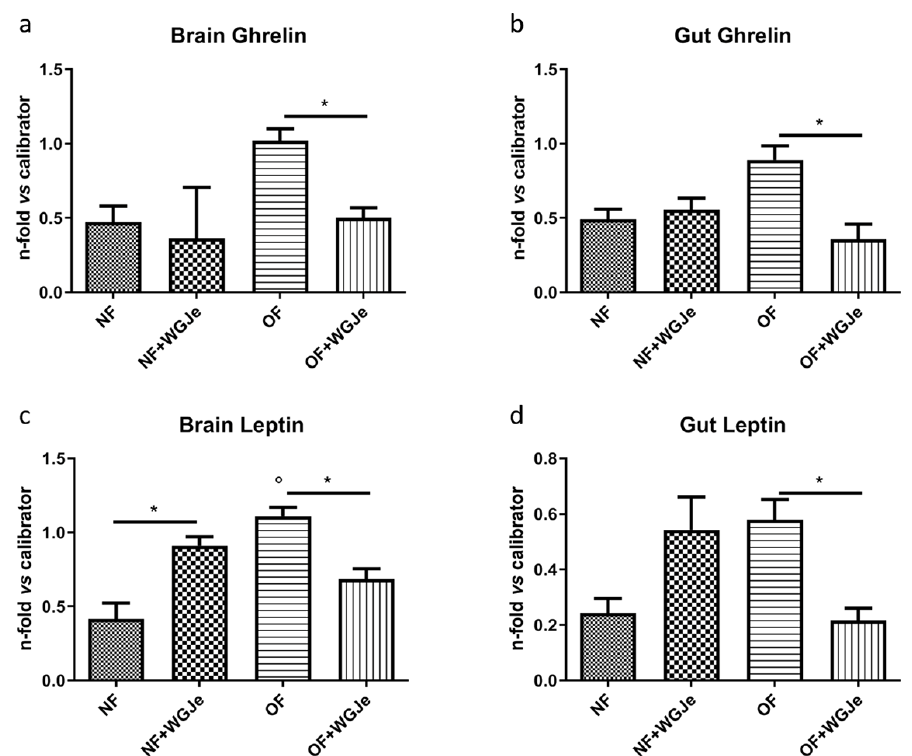
Figure 6. Effect of WGJe on the expression level of food-intake related genes. The expression of ghrelin ( a , b ) and leptin A ( c , d ) mRNA levels were investigated by qPCR analyses versus an arbitrary calibrator in both brain and gut of the normal fed (NF) and overfed (OF) groups, with and without WGJe treatment. Relative quantities of mRNA were calculated using the 2 −ΔΔ Ct quantification method. Results are expressed as fold change in WGJe-treated fish compared to those found in untreated ones after normalization to β -actin . Data represent the mean ± SD of five animals for each group. * p < 0.05 vs. respective counterparts; ° p < 0.01 vs. NF.